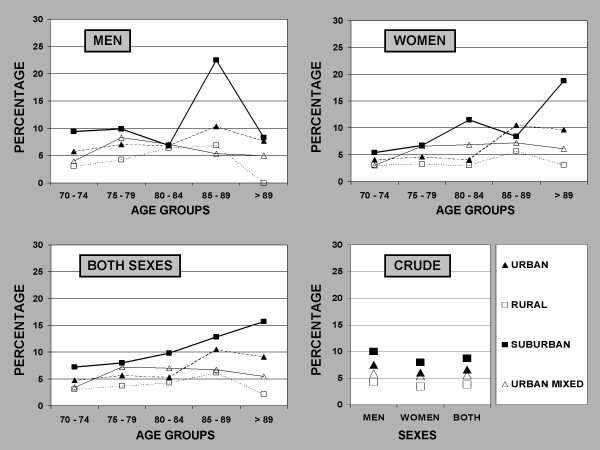
Crude and age-specific prevalence of stroke in Spanish populations grouped by habitat.